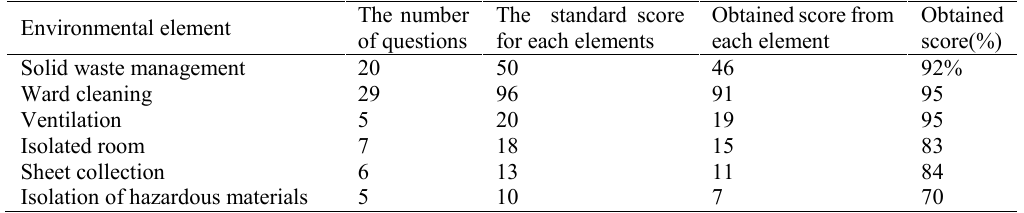
Table 3. Indoor environment score (%) according to environmental health checklist Environmental element